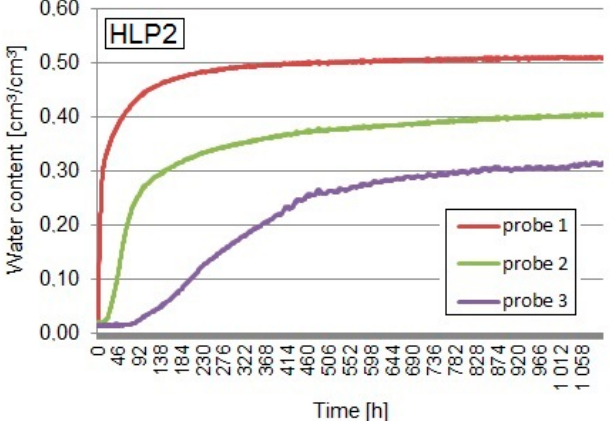
Figure 8. Capillary uptake of the HLP1 composite.